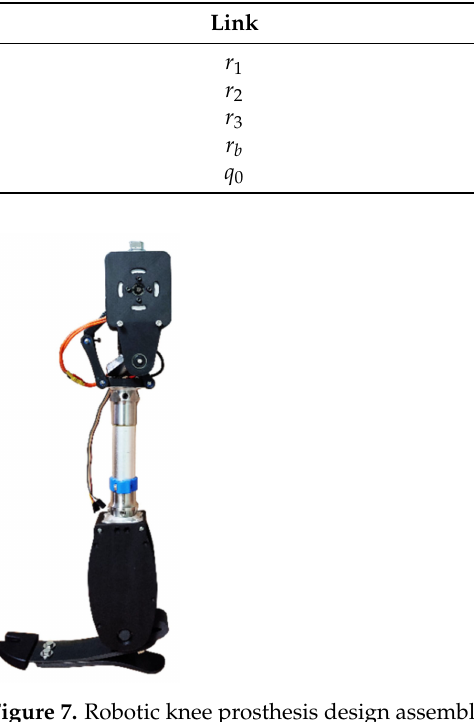
Figure 7. Robotic knee prosthesis design